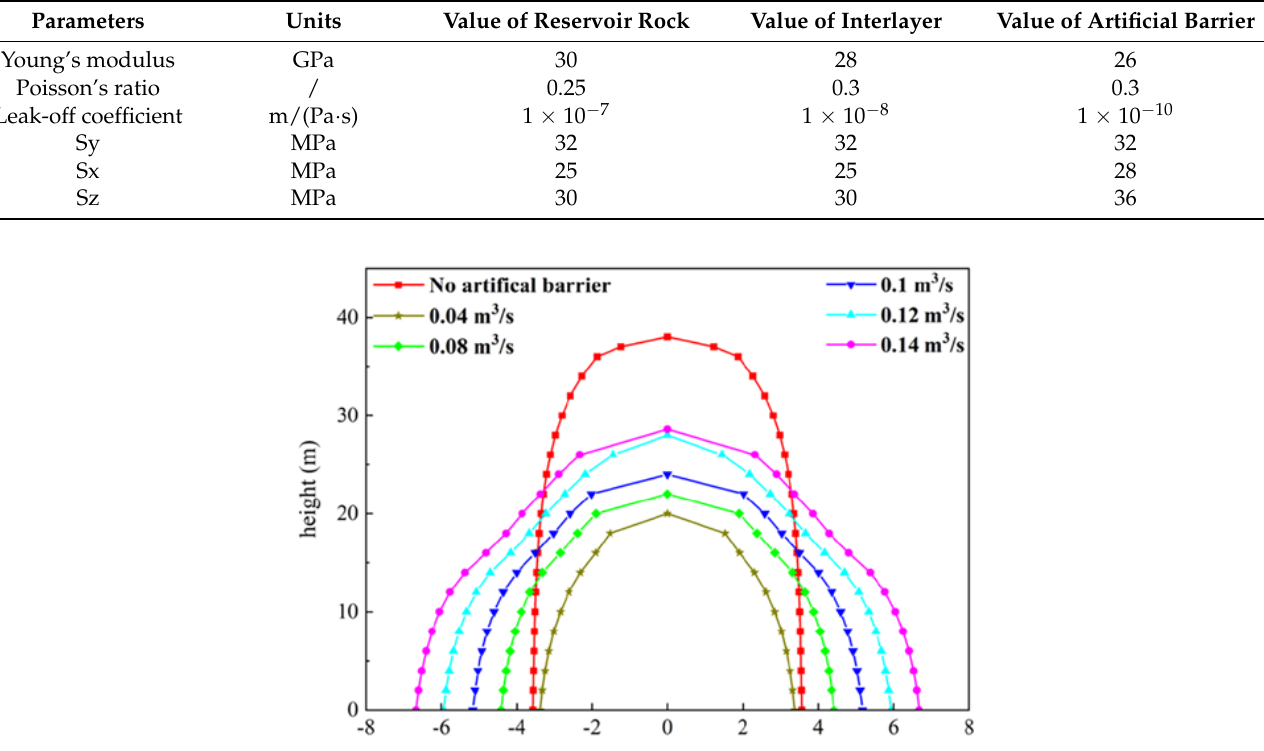
Table 4. The rock mechanics parameters of the stratum.